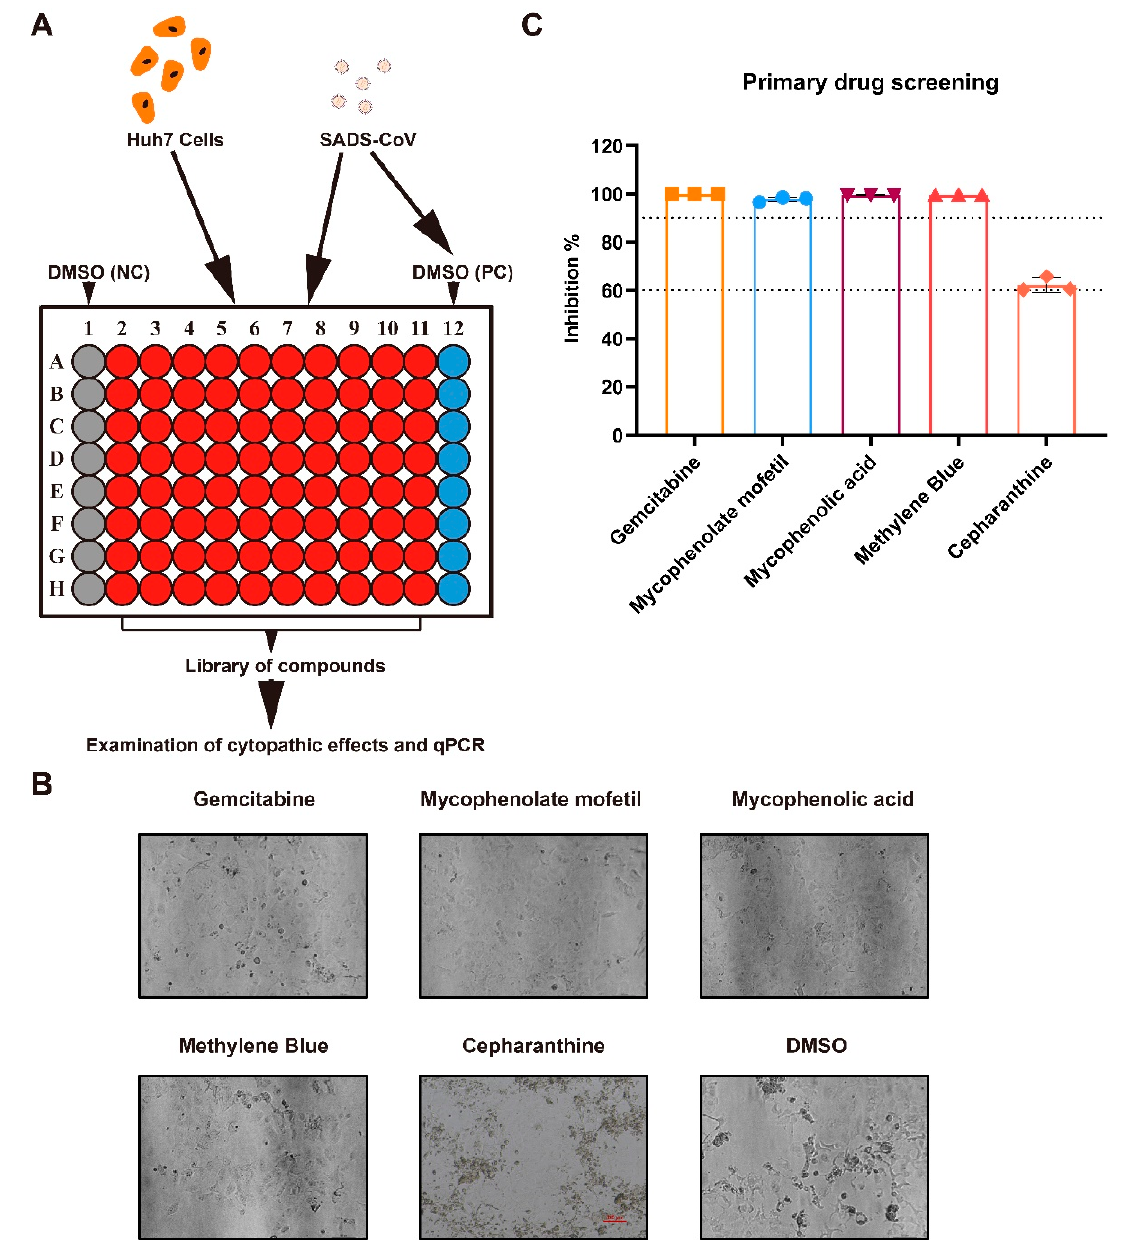
Figure 1. Primary screening for anti-SADS-CoV compounds. ( A ) Overview of antiviral compound screening. Huh7 cells were seeded in 96-well plates, then treated with SADS-CoV (MOI 0.1) and each compound to a final concentration of 10 µ M (containing less than 0.1% DMSO). ( B ) The representative images of CPE on Huh7 cells incubated with SADS-CoV and the five compounds. Images were captured at 48 h post-infection (hpi) under 10 × objective. ( C ) The inhibitory rates of gemcitabine, mycophenolate mofetil, mycophenolic acid, methylene blue and cepharanthine are shown. Cells incubated with dimethyl sulfoxide (DMSO) and virus were regarded as the positive control (PC), and negative control was treated with 0.1% DMSO only. The viral RNA expression levels in the cells were quantified by qPCR and normalized to GAPDH, and the compound inhibitory rates were calculated compared to PC. Data represent the mean of the three replicate results. Error bars represent ± 1 SD, and the experiments were repeated at least